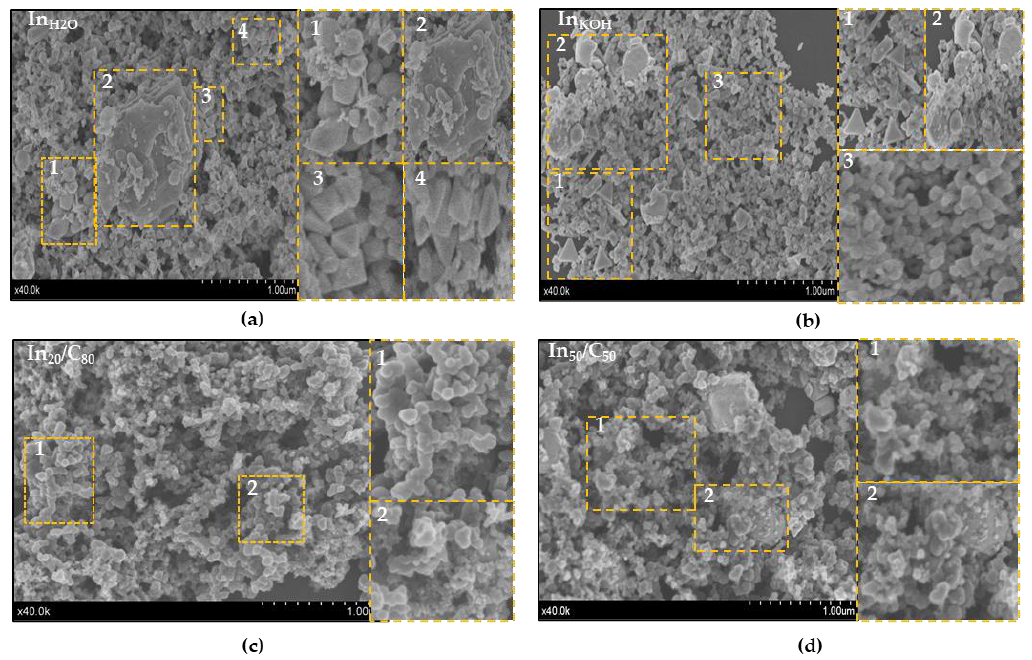
Figure 2. Representative SEM images of: ( a ) In nanoparticles washed with H 2 O; ( b ) In nanoparticles washed with KOH. In nanoparticles supported on carbon: ( c ) 20/80 wt. %; ( d ) 50/50 wt. %. Some enlargements of the SEM images are included for facilitating the interpretation.